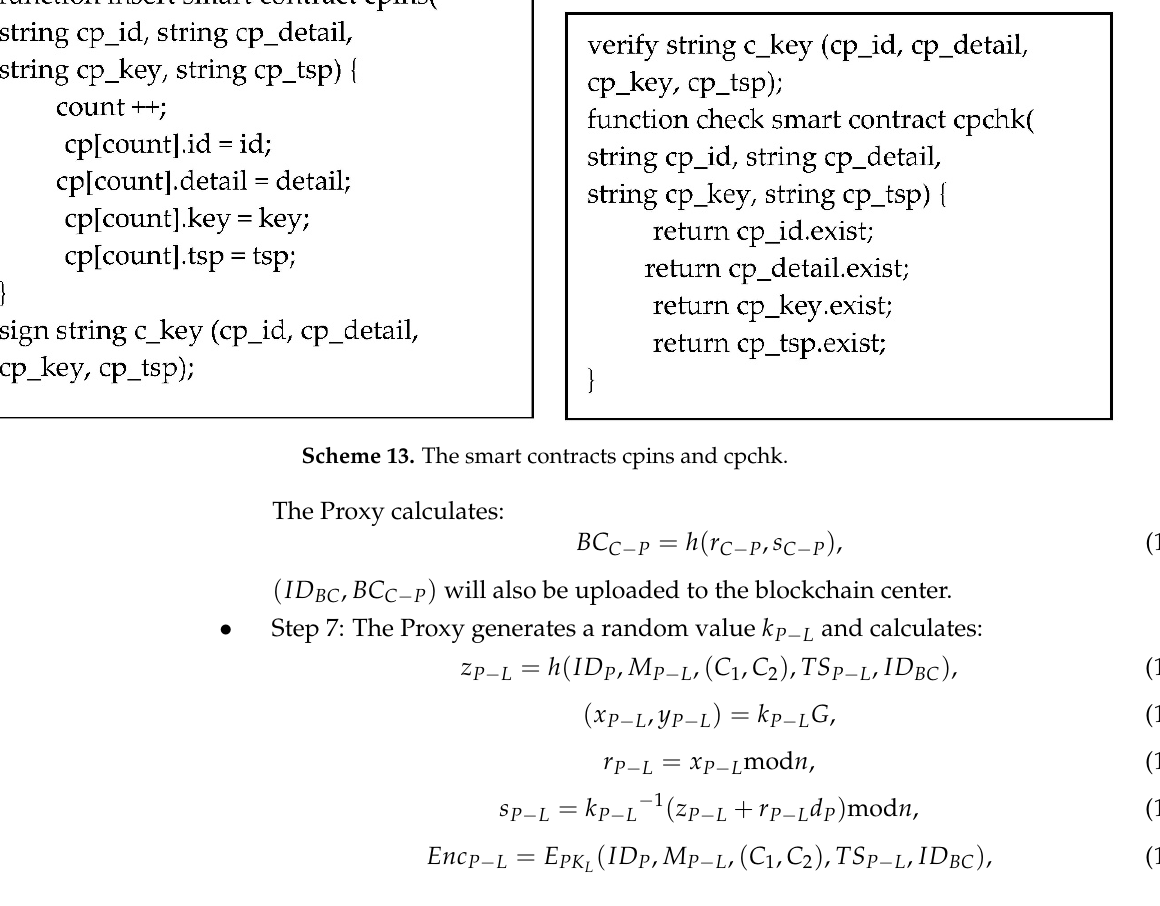
Figure 15. Payment verification and browsing phase (P to L).